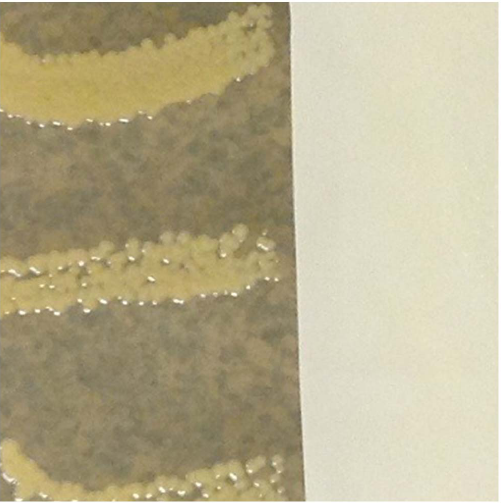
Figure 1. Typical results, latex gloves with inhibition of Staphylococcusaureus demonstrated.